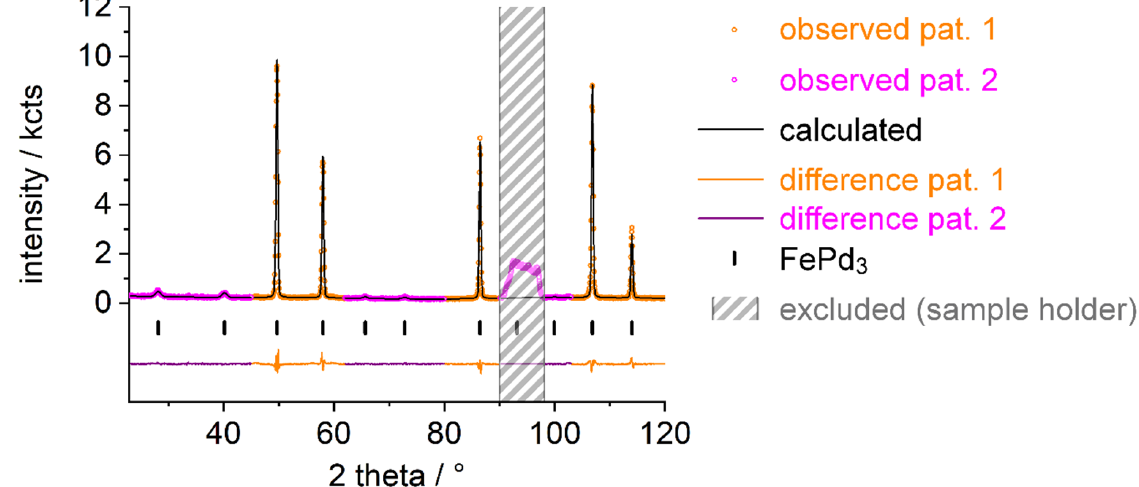
Figure A15. Rietveld refinement of the crystal structure of FePd 3 D 0.045(9) (for details, see third row in Tables A8 and A9) based on neutron powder diffraction data (NUMOR 131760 [21], λ = 186.80(2) pm, D20 ILL, Grenoble) in a single-crystal sapphire cell at 348(3) K and 8.06(1) MPa deuterium pressure using FullProf [24].